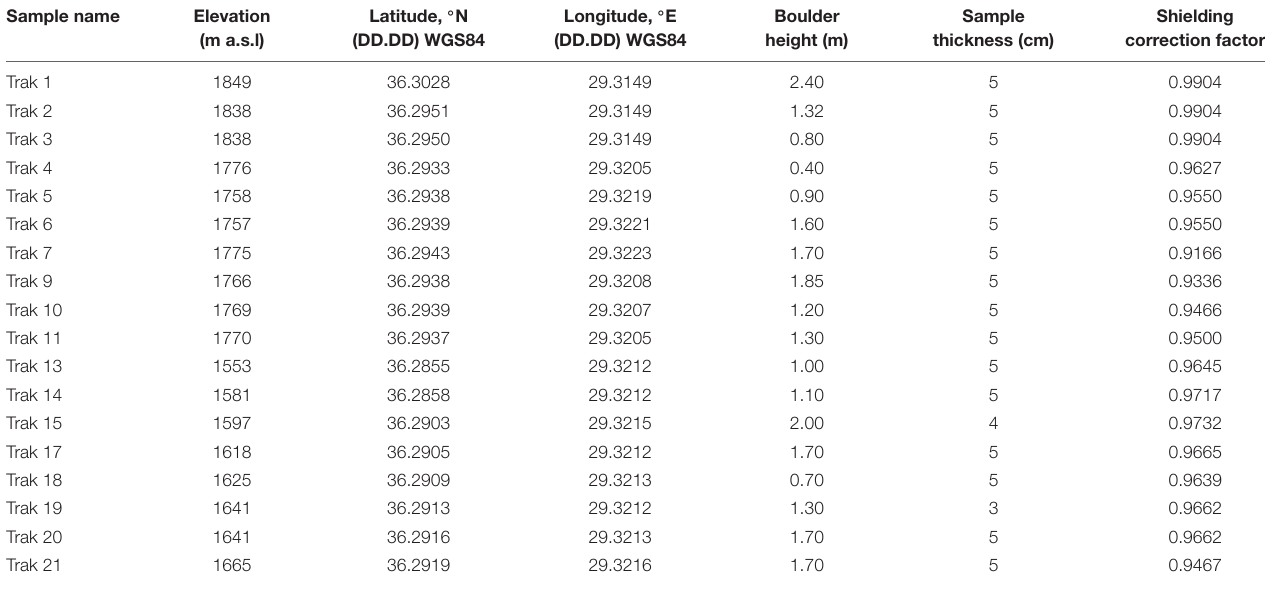
TABLE 1 | Description of samples from Akdag landslide